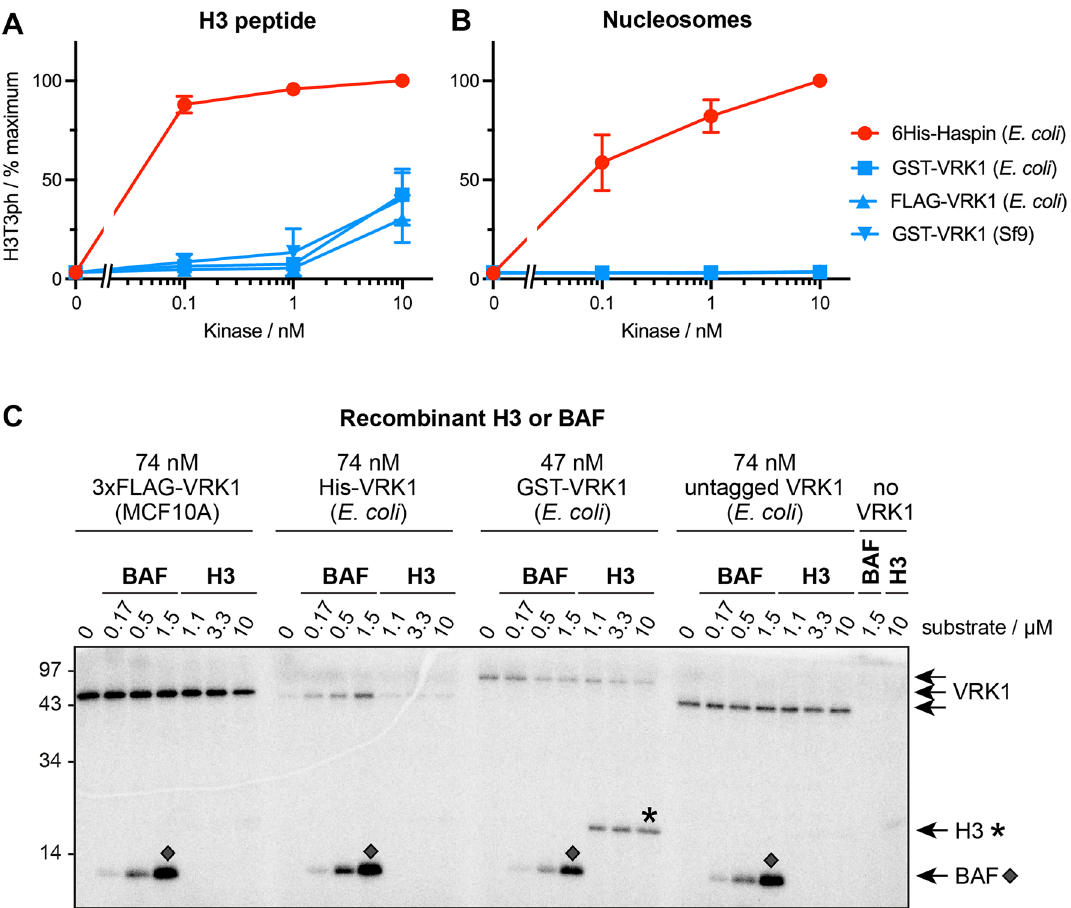
Figure 1. Phosphorylation of Histone H3 and BAF by recombinant human Haspin or VRK1. Phosphorylation of H3T3 by Haspin and VRK1 on ( A ) H3(1–21) peptides, and ( B ) recombinant nucleosome substrates, detected by H3T3ph antibodies. Error bars show means ± SD, n = 3 independent experiments. In ( C ), phosphorylation of recombinant BAF or H3 by various preparations of recombinant VRK1 were monitored by [γ 32 P]-incorporation, SDS-PAGE and phosphorimaging analysis. The integrity and purity of the proteins was validated by SDS-PAGE and silver-staining. The original gel is presented in Supplementary Fig. VRK1 and VRK2 were never within the top 30% and were most often in the bottom 20% of kinases (Fig. 2F; Supplementary Fig. 2). Of note, another kinase that has been proposed to phosphorylate a number of sites on Haspin was reproducibly identified as the most likely mitotic H3T3 kinase in HeLa cell extracts.